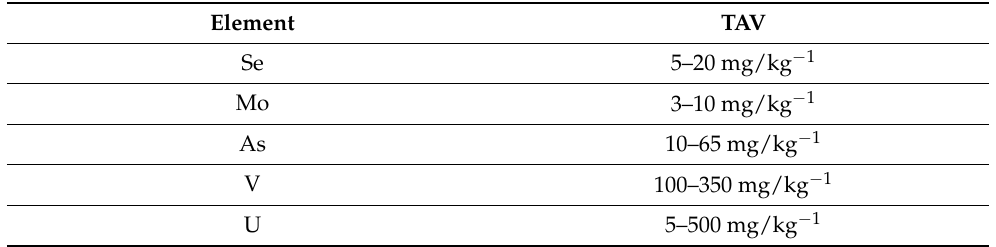
Table 9. Trigger action values (TAVs) and upper safe limits for elemental concentrations in agricultural soils vary [1,49,50] and bioavailability is highly dependent on elemental species. Most publications quote the lower limits for Se, and Mo presented here